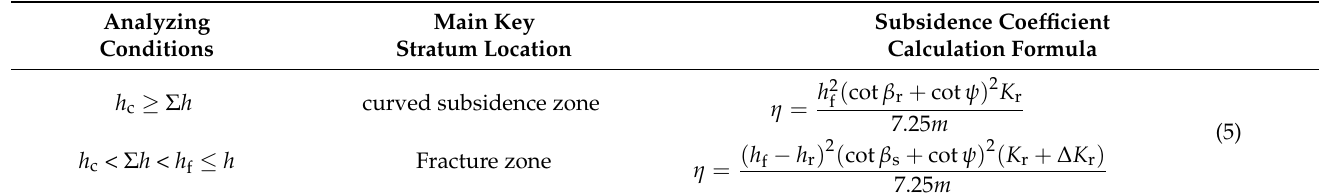
is located at different positions. Table 1. The subsidence coefficient of the main key stratum at different